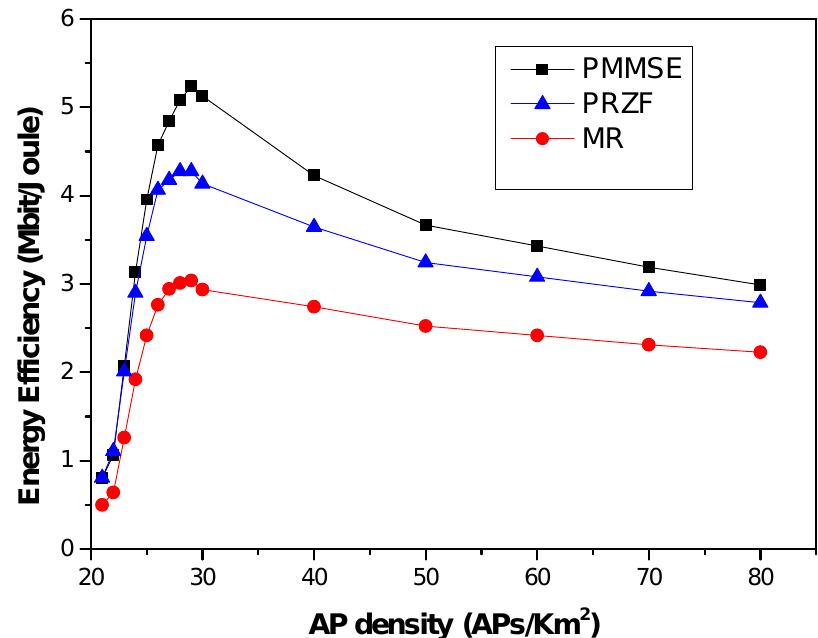
Figure 5. Energy efficiency as a function of AP density for different receive combiners.